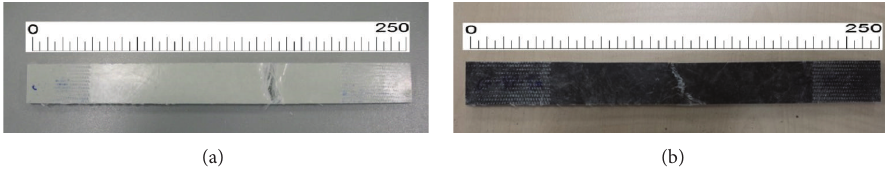
Figure 4: Broken test specimens, (a) filled with CaCO 3 and (b) filled with basalt